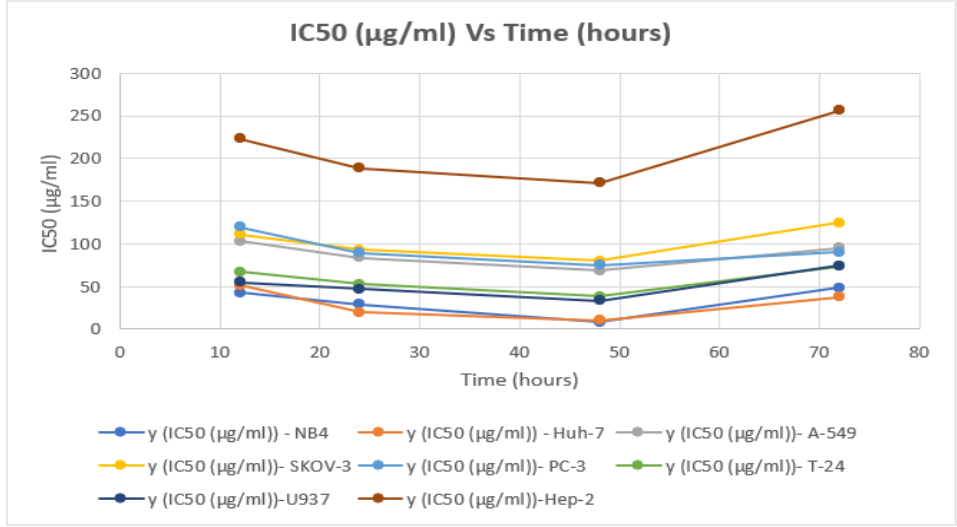
Figure 3. Findings IC50 (5–300 µg/mL) of P. amygdalus var . amara with time (h) for 8 cancer cell lines. The lowest value of cell viability was recorded at an IC50 concentration of 8.22 ± 0.04 µg/mL, and it was 34.65%, which was compared to that of cells not treated with the extract (98.34%) after 48 h of the incubation period (Tables 2 and 3). Moreover, it decreased after 24 h. of incubation, as the value of cell viability decreased from 98.59% to 62.76% at 29.06 ± 0.141 µg/mL (Figure 4).